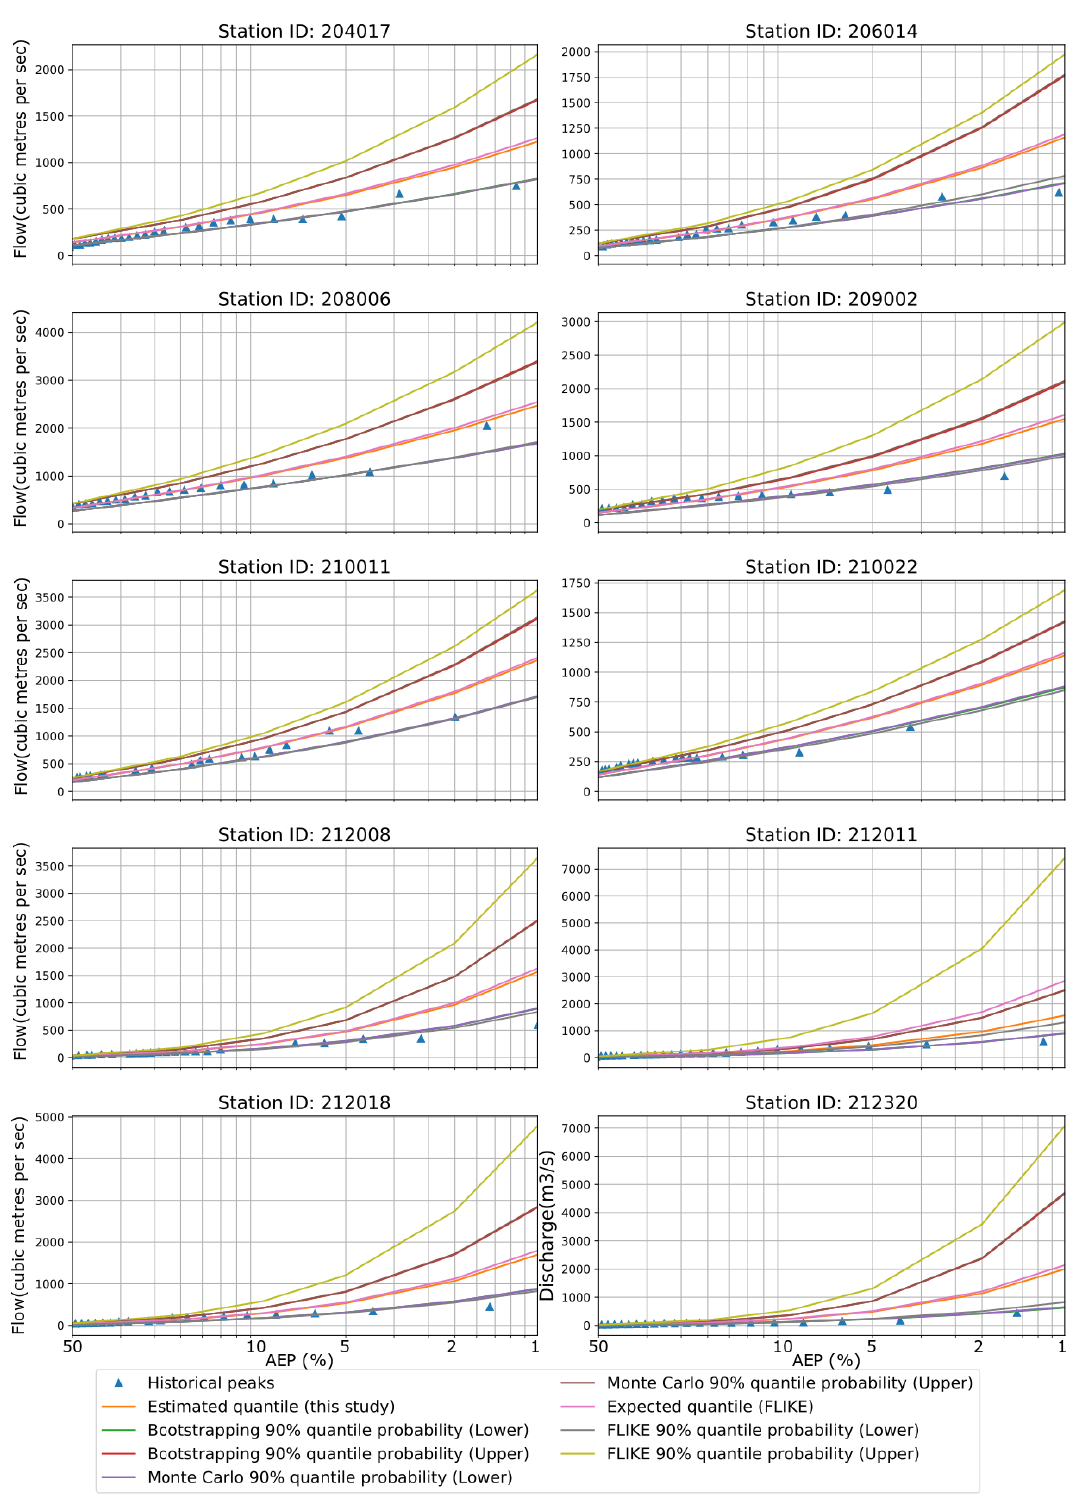
Figure 6. Flood quantiles from FLIKE and LN distribution are presented over various AEPs for all 10 stations. CIs are estimated by FLIKE, BS and MCST. The blue triangle symbolizes historical